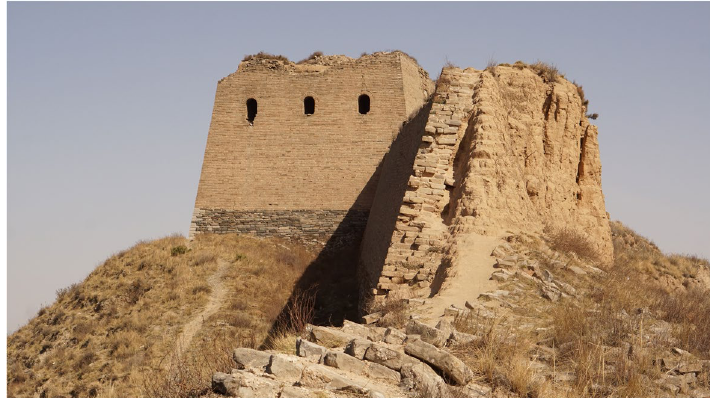
Fig. 9 One of the typical construction profiles with rammed earth as the core, natural stone as the foundation, and fired bricks as the outer masonry wall and wall coping. The interior of the wall consisted only of rammed earth without brick masonry, Shanxi Province (Source: Tongji-ACL)